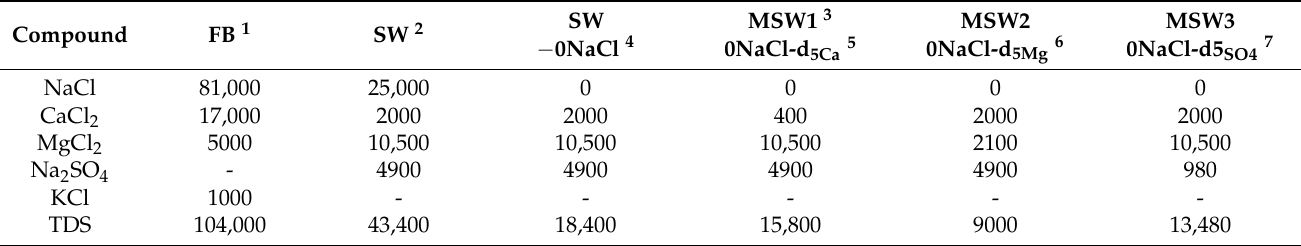
Table 4. Composition of the formation and injected brine [95] (mg/L).